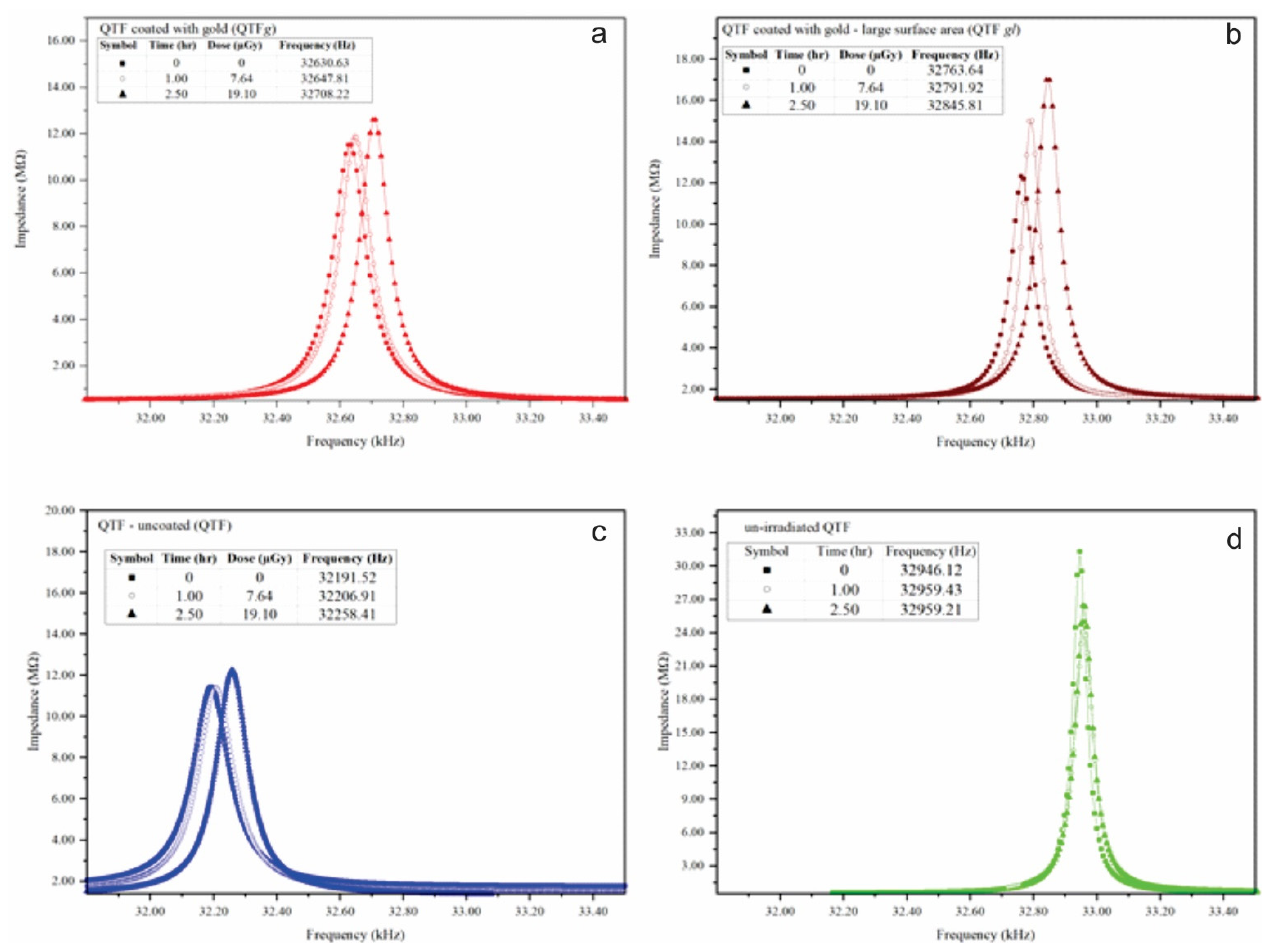
Figure 2. Resonance frequency shift of ( a ) QTF g QTF, ( b ) QTF gl , and ( c ) uncoated QTF in response to gamma radiation. ( d ) represents the QTF response without exposure to gamma radiation.